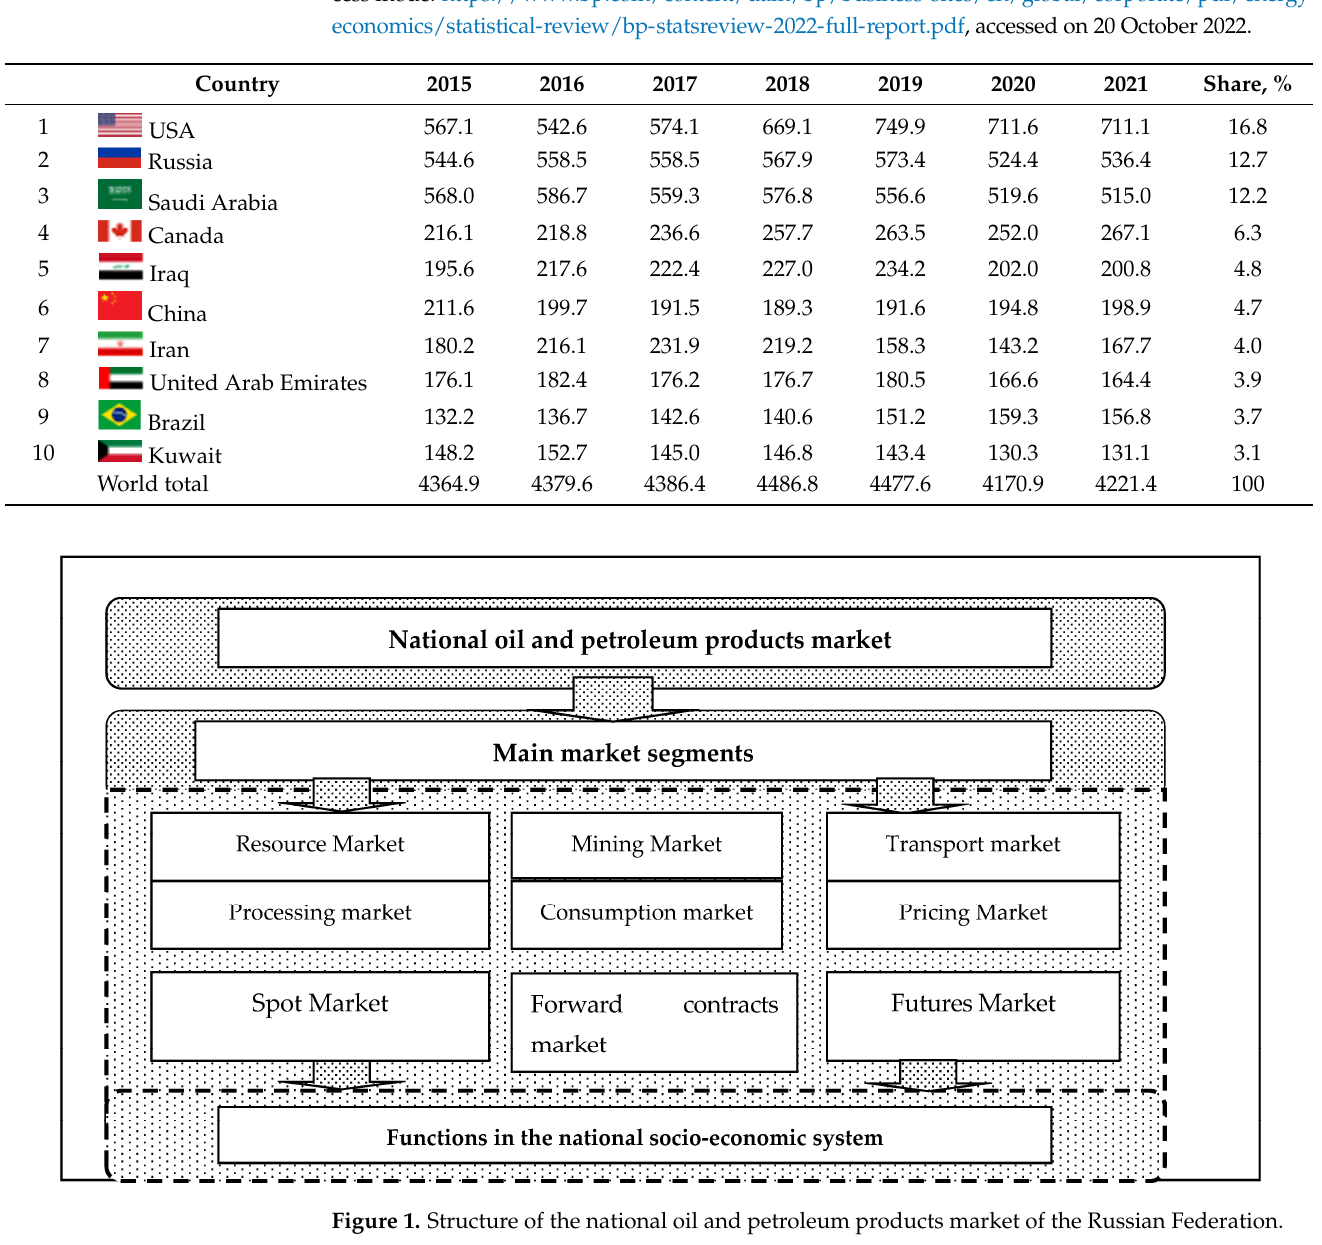
Table 1. Ranking of the world’s countries by proven oil reserves, 2020. (Oil reserves in the world by country list 2021. Proven reserves. [electronic resource]. Access mode: https://www.xn-----7kcbmk-